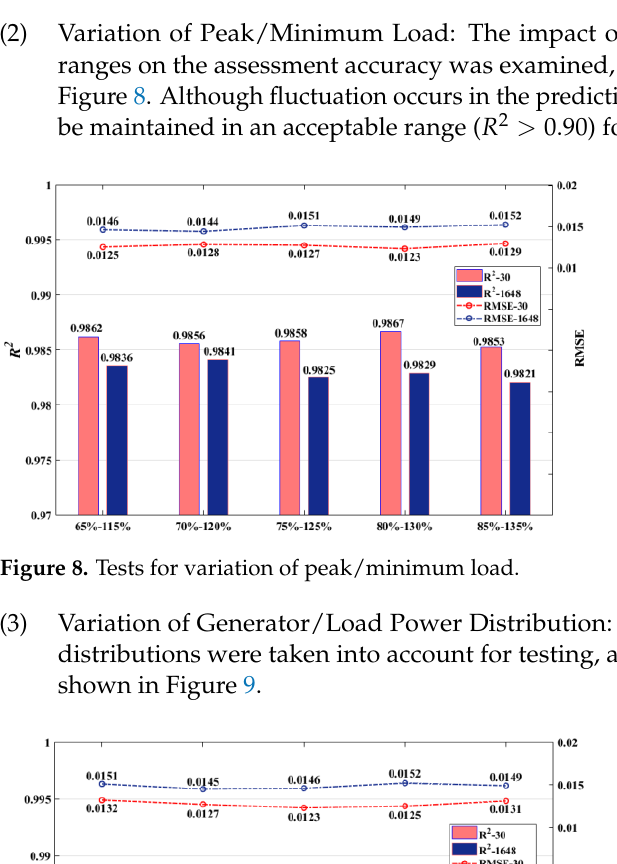
Variation of Peak/Minimum Load: The impact of different peak/minimum load